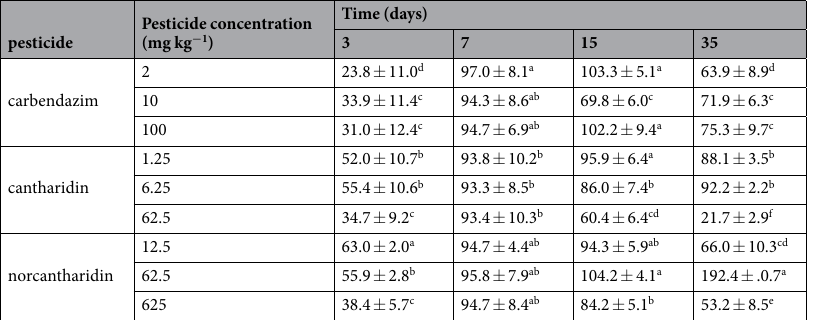
Table 1. Effect of carbendazim, cantharidin and norcantharidin on the treated–soil quantity (T-SQI) at 3, 7, 15, 35 days of incubation in the presence of different concentrations of pesticides. Mean values (n = 3) ± S.D. values followed by different letters are significantly different at each incubation time according to Fisher’s PLSD test (P < 0.05). Reference value (100%): pesticide-free controls.